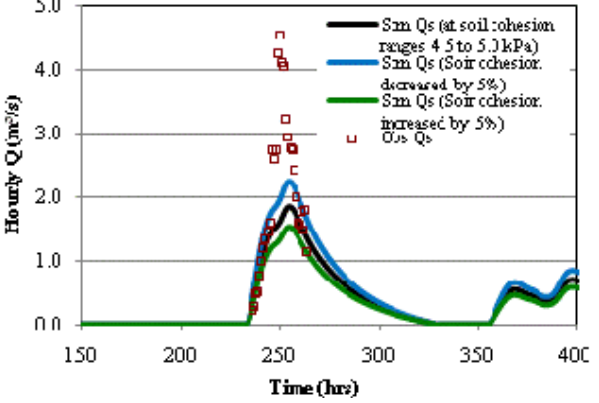
Fig. 15. Q s with different soil cohesion values at Tateyama station. Fig. 15. Qs with different soil cohesion values at Tateyama station. Fig. 15. Q S with different soil cohesion values at Tateyama station.